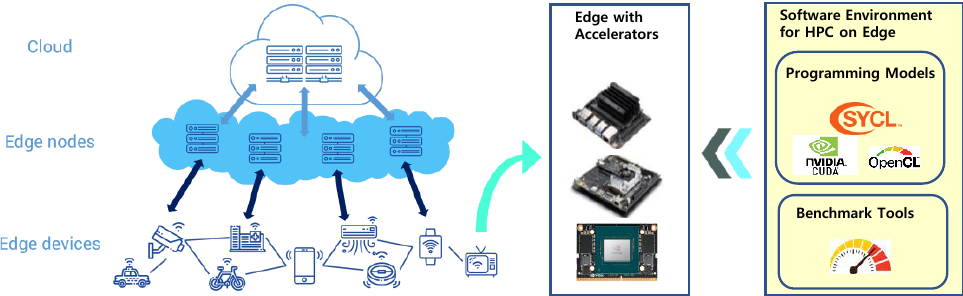
Figure 1. An overview of software environments for HPC on